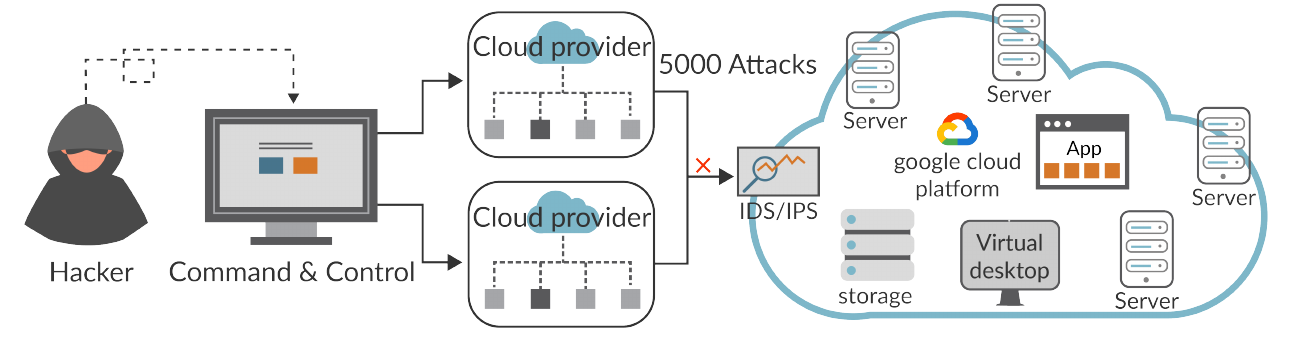
Figure 4. Attacks from outside the cloud.